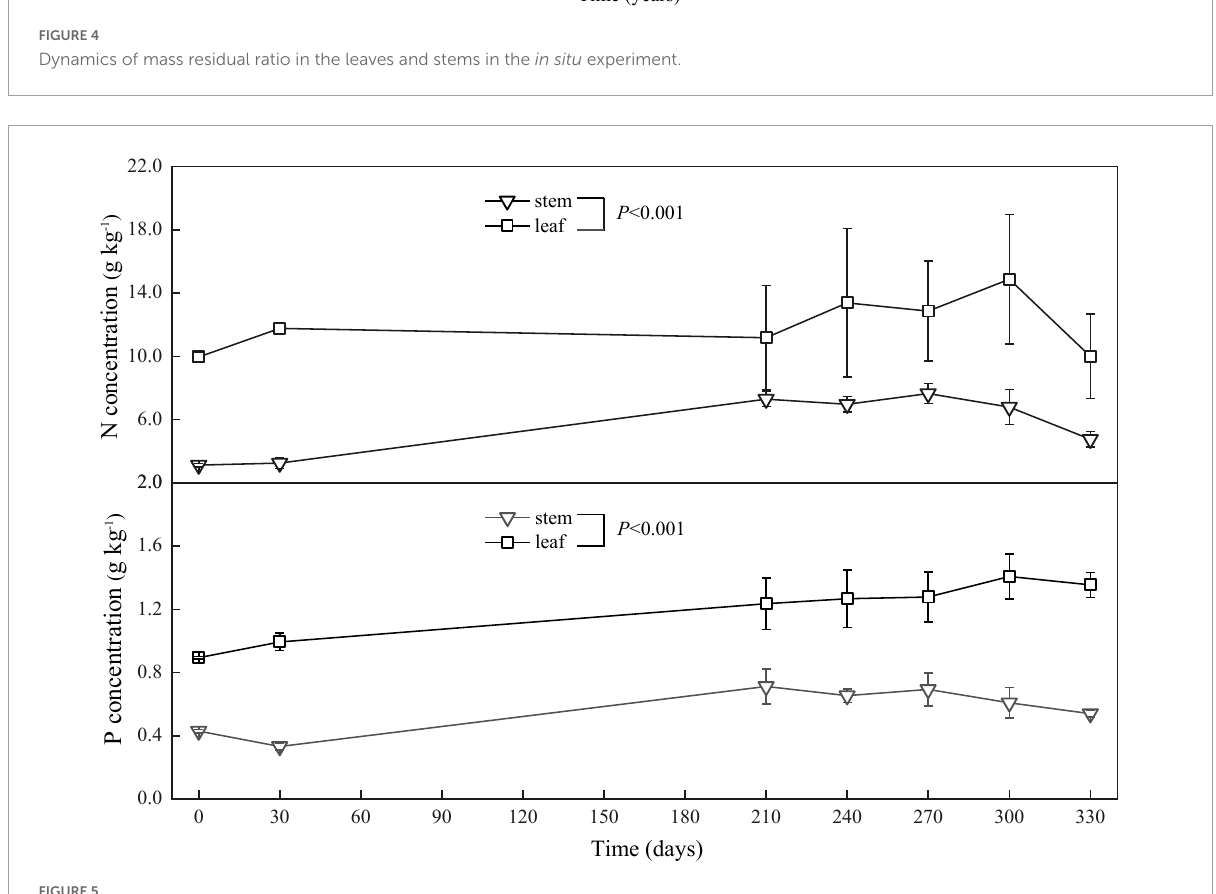
phosphorus. Another possible reason could be that leaves can absorb some elements from water during prolonged flood periods (Bonanno and Giudice, 2010). Combined with